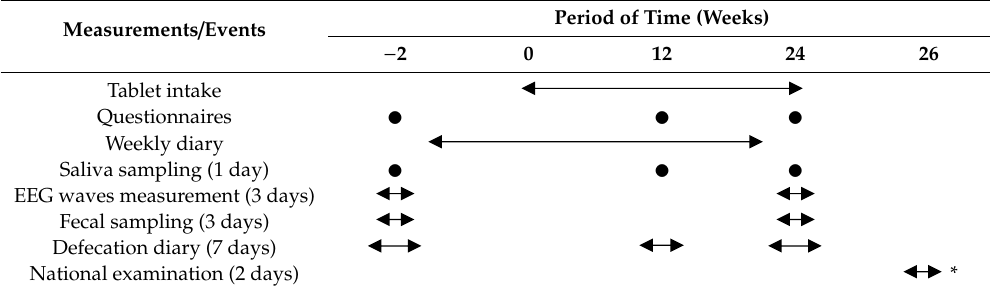
Table 1. Experimental schedule.